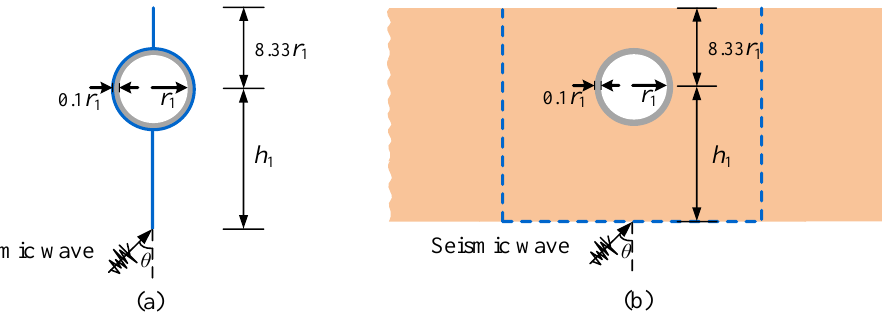
Figure 6. Amplification of radial displacement along the external tunnel surface: ( a ) P wave vertically incident and ( b ) SV wave vertically incident.